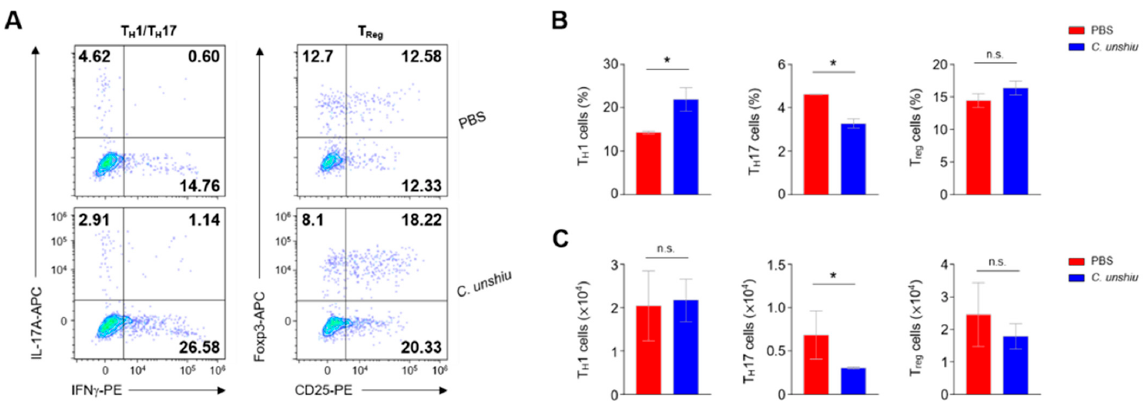
Figure 4. CUP decreases the frequency of T helper 17 (Th17) cells in the lamina propria of large intestine. ( A ) Representative images of the flow cytometry analysis of TH1 (CD45 + CD4 + IL17a- IFN γ +), Th17 (CD45 + CD4 + IL17a + IFN γ− ), and Treg (CD45 + CD4 + CD25 + Foxp3+) cells in the lamina propria of large intestine. The summary graphs indicate the frequency ( B ) and absolute numbers ( C ) of immune cells ( n = 3 per group). All data are represented as the mean ± SEM of independent experiments. Statistical analyses were conducted using unpaired t -tests. * p < 0.05; n.s., not sig-